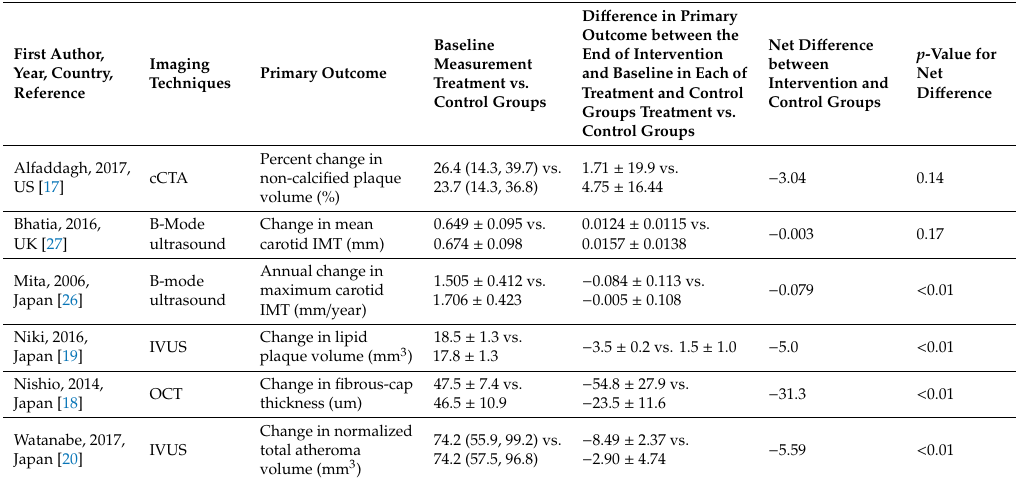
Table 2. Primary outcome of atherosclerosis and the result of each included trial.